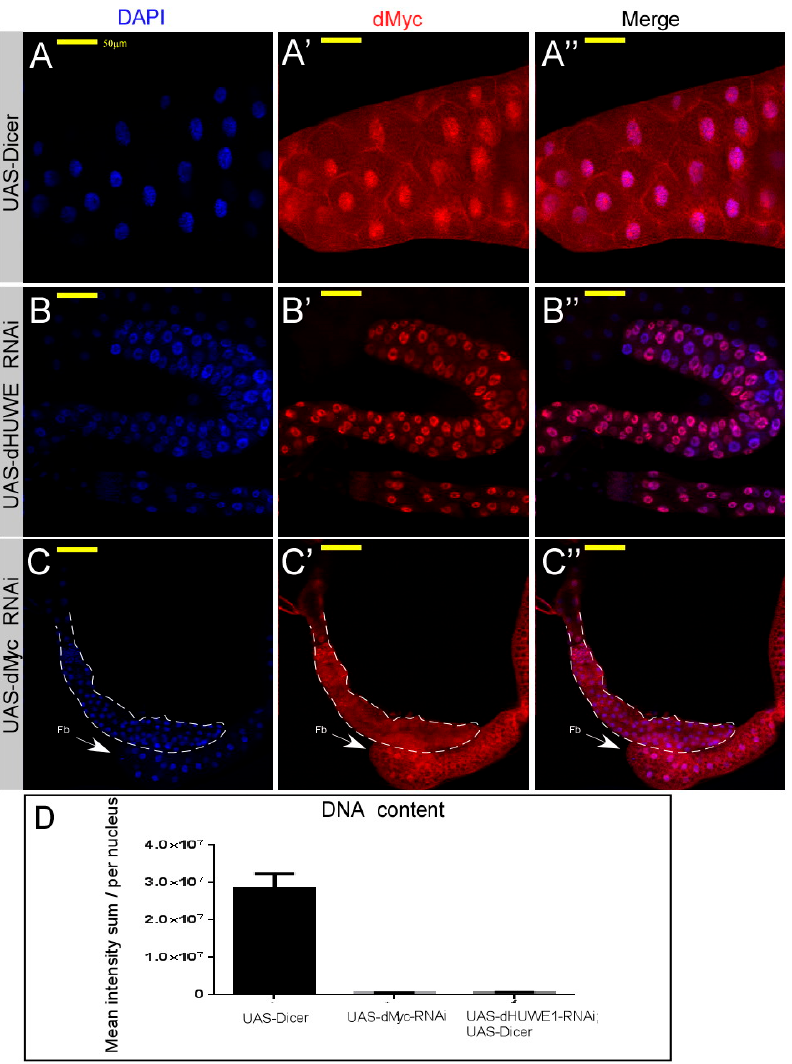
Figure 2. Loss of dHUWE1 results in a small salivary gland that expresses dMyc protein. ( A–C” ) Indirect immunofluorescence confocal microscopy images of wild-type ( A – A” ) and the indicated UAS-RNAi transgenic lines (dHUWE1, B – B” ; dMyc, C – C” ) immuno-stained with anti-dMyc antibody (red). DAPI (blue) marks DNA, and the scale bar is 50 µ m. The dotted line in C – C” indicates the edges of the small salivary gland. Fb; fat body tissue. ( D ) Indirect quantification of the DNA content of salivary gland cells derived from the indicated transgenic lines using Imaris technology® ( n = 10 p < 0.001).